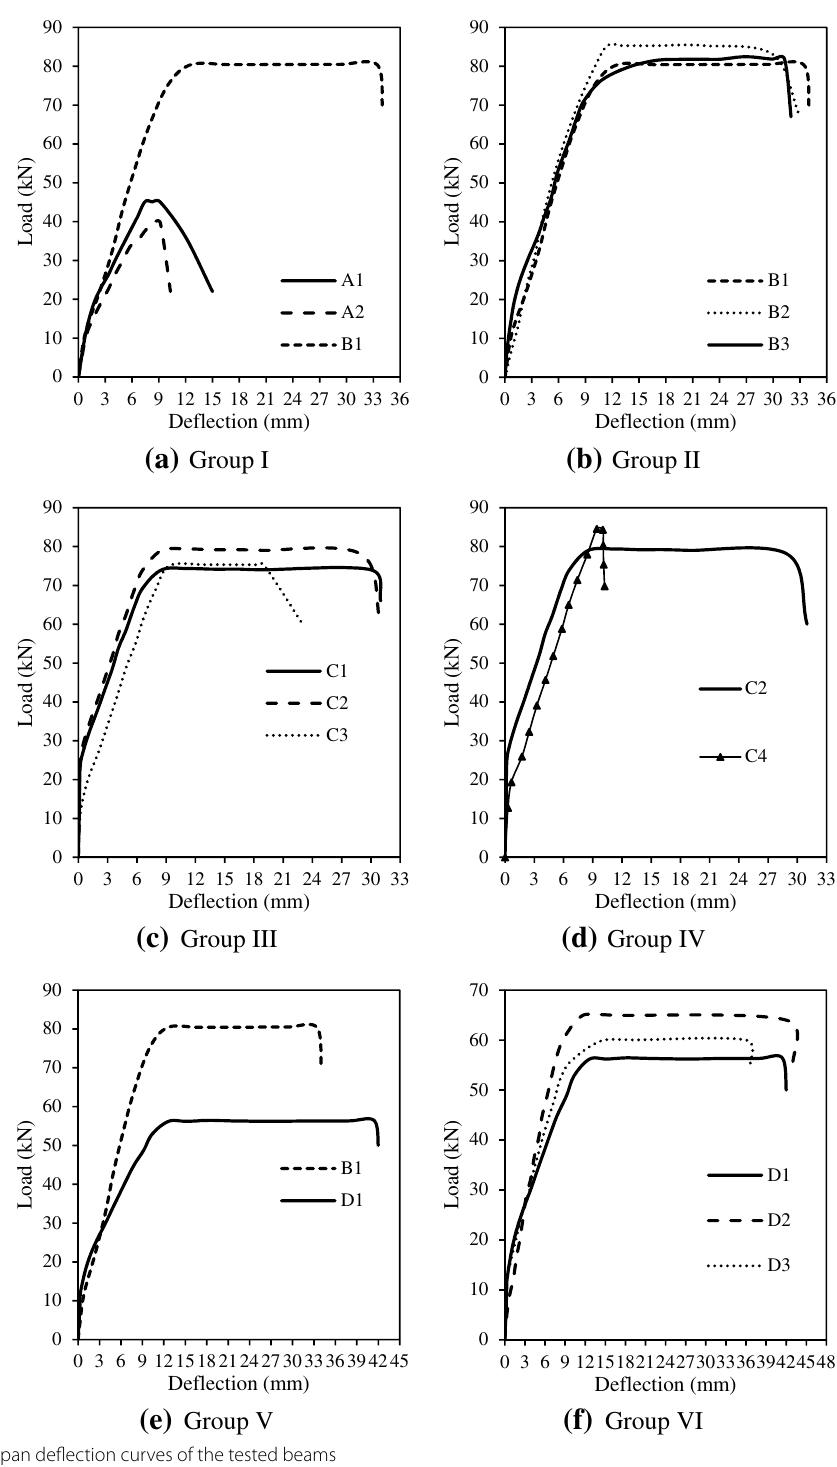
Fig. 14 Load–mid-span deflection curves of the tested